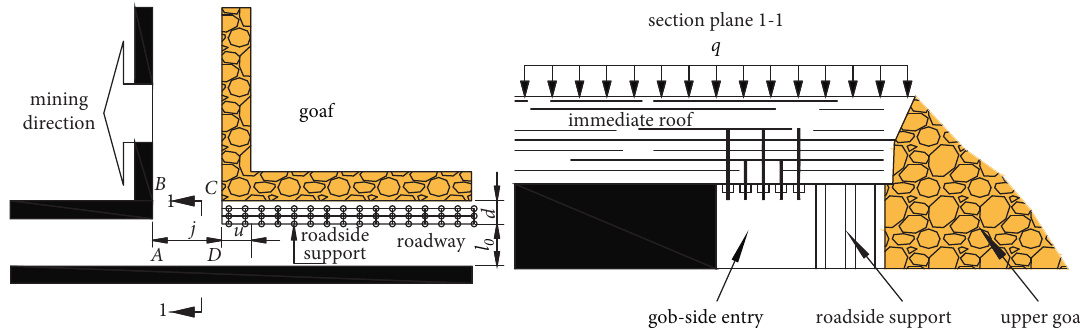
Figure 7: Mutual mechanical model of the support near the entry retaining and immediate